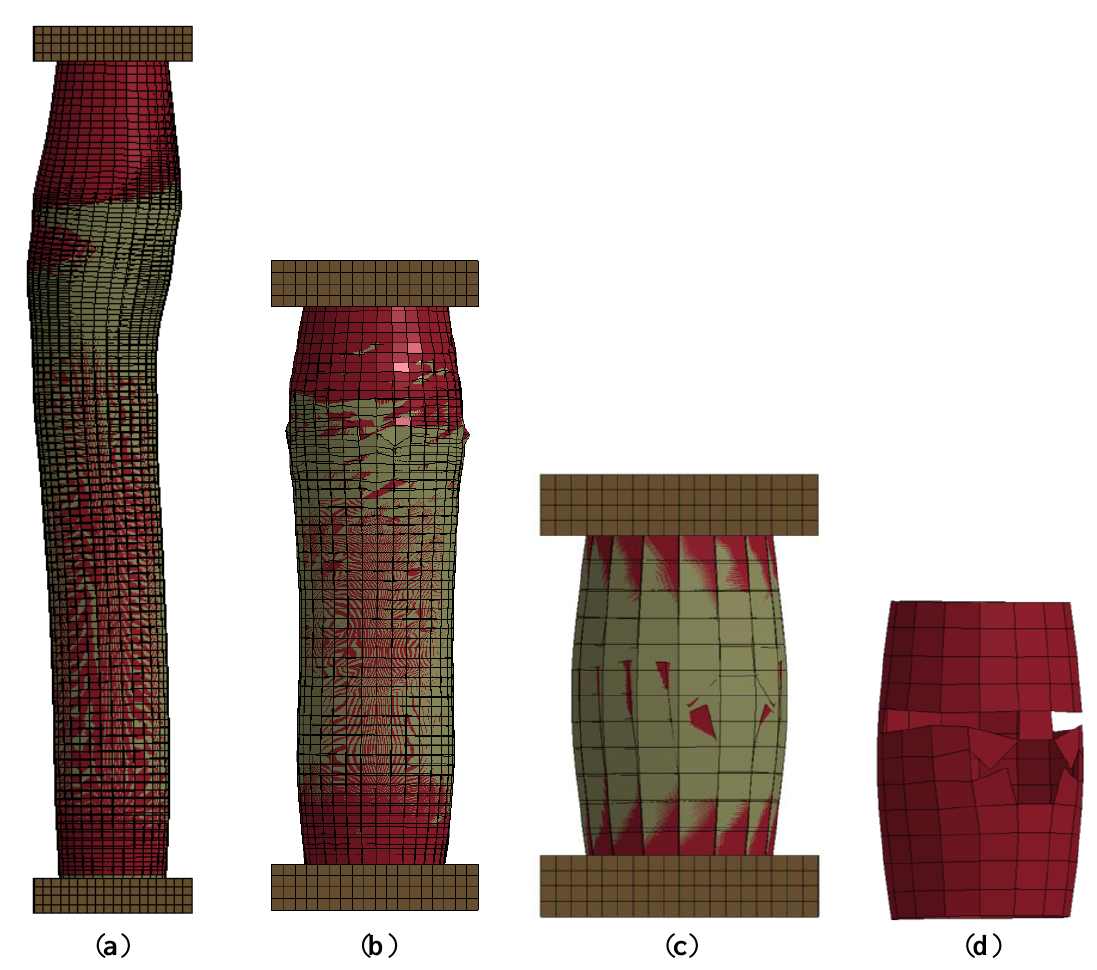
Figure 11. Column deformation with different aspect ratios: ( a ) aspect ratio of 10; ( b ) aspect ratio of 5; ( c ) aspect ratio of 2; and ( d ) FRP rupture of column with aspect ratio of